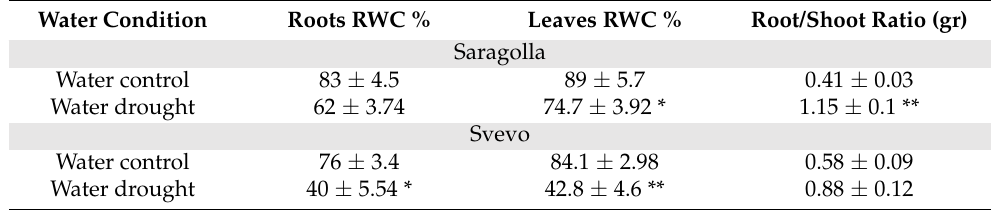
Figure 1. Effect of water stress on the growth of Svevo and Saragolla cultivars. ( A ) Phenotype of seedlings of Svevo (left) and Saragolla (right) seedlings grown for 17 days under control conditions. ( B ) Phenotype of Svevo (left) and Saragolla (right) seedlings grown under control conditions and then subjected to 10 days of osmotic stress by means of 18% PEG-6000 administration, as described in Section 4.1. Table 1. Determination of roots and leaves RWC and of root-to-shoot ratio of Svevo and Saragolla seedlings cultivated with full water availability or subjected to osmotic stress by means of 18% PEG-6000 administration for 10 days, as reported in Section 4.2. Results from three independent experiments are reported; values are expressed as the mean ± SD. Statistical significance was attributed by one-way ANOVA test (* p < 0.05, ** p < 0.01).